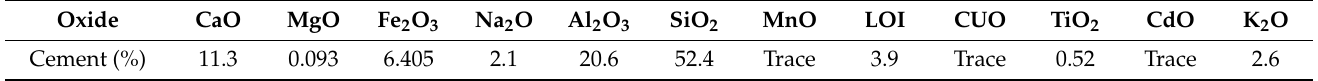
Table 5. Chemical properties of